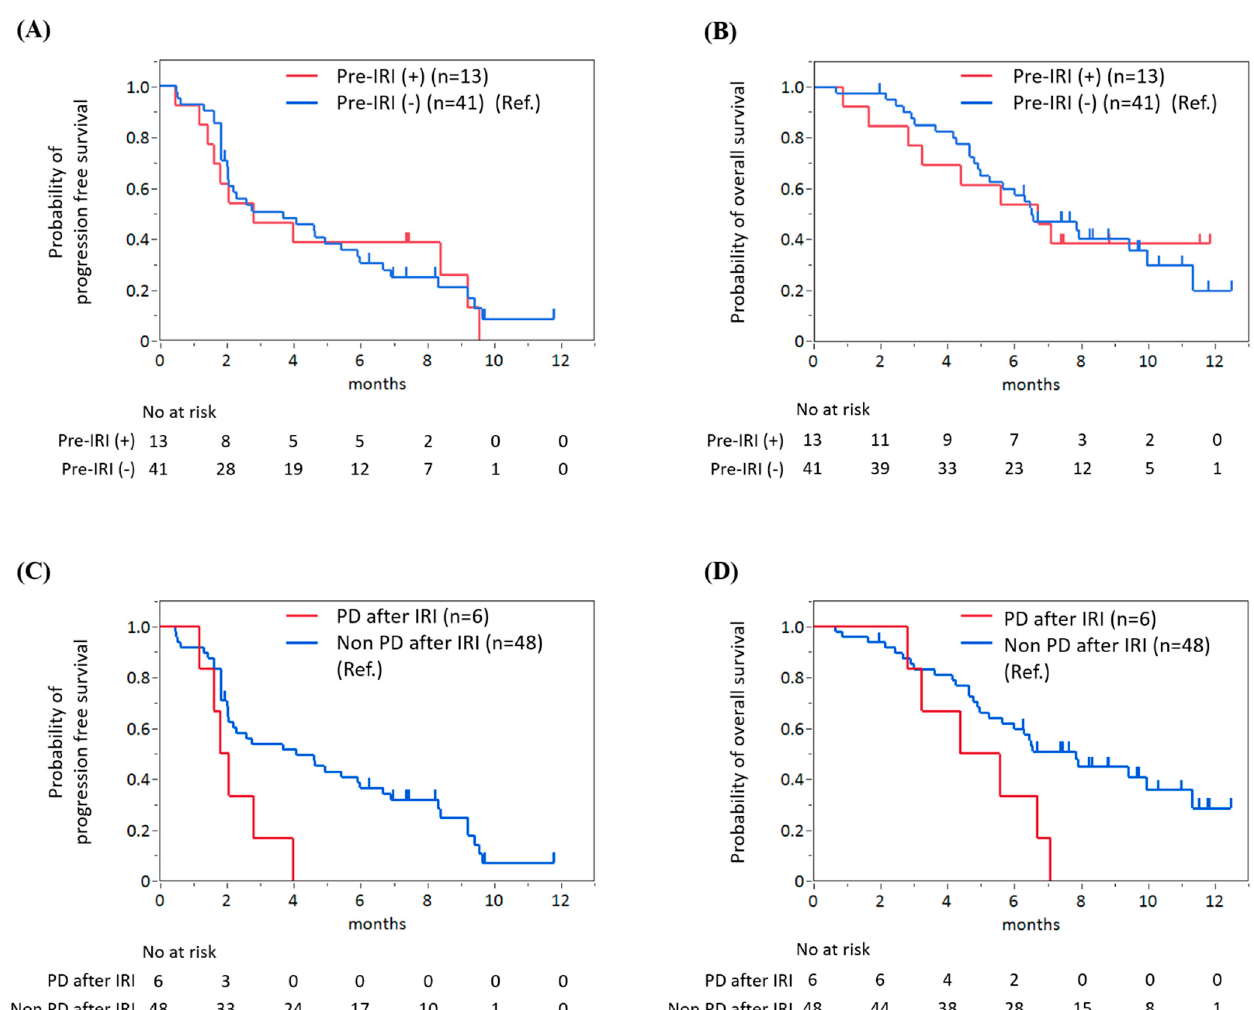
Figure 3. No significant difference in progression-free survival (PFS) ( A ) and overall survival (OS) ( B ) was found between patients with and without prior irinotecan therapy. However, patients with disease progression after irinotecan-containing chemotherapy had significantly shorter PFS ( C ) and OS ( D ) than other